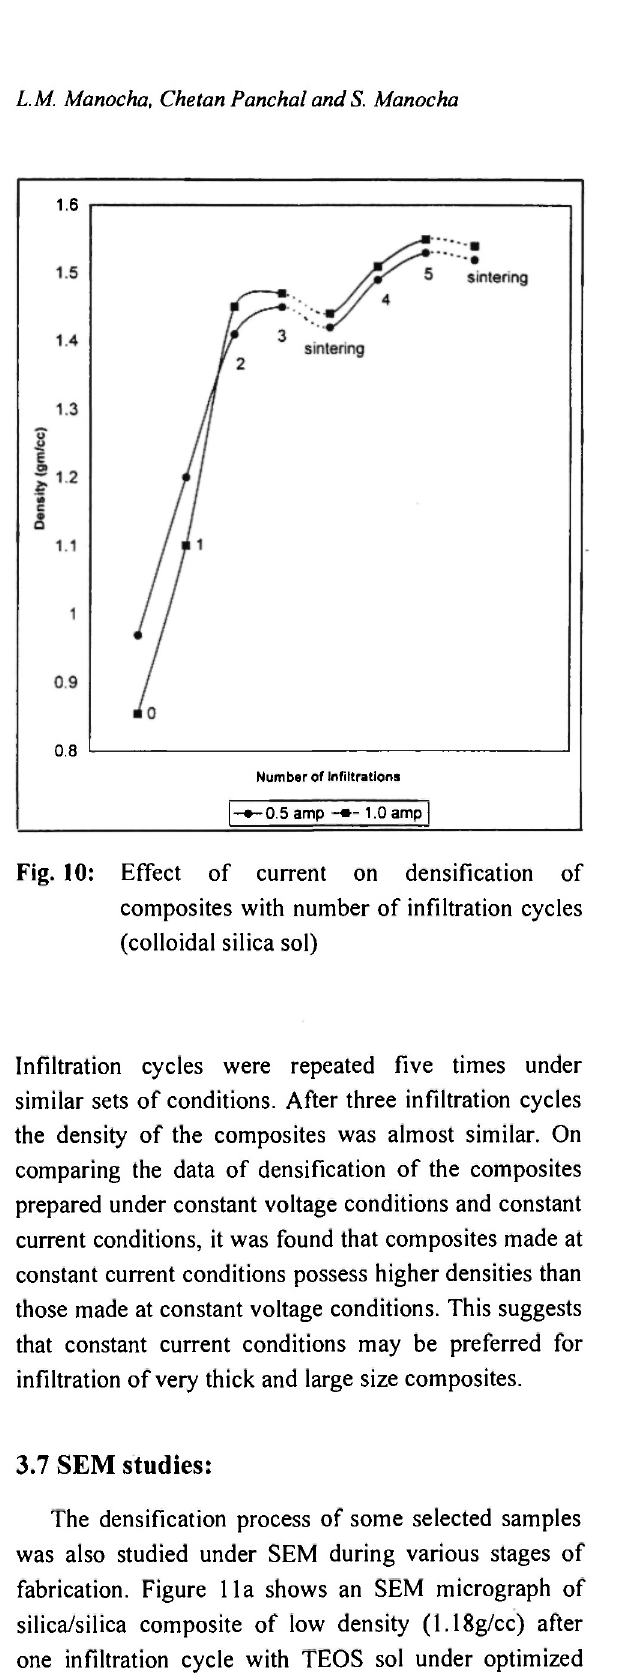
Effect of current on densification of